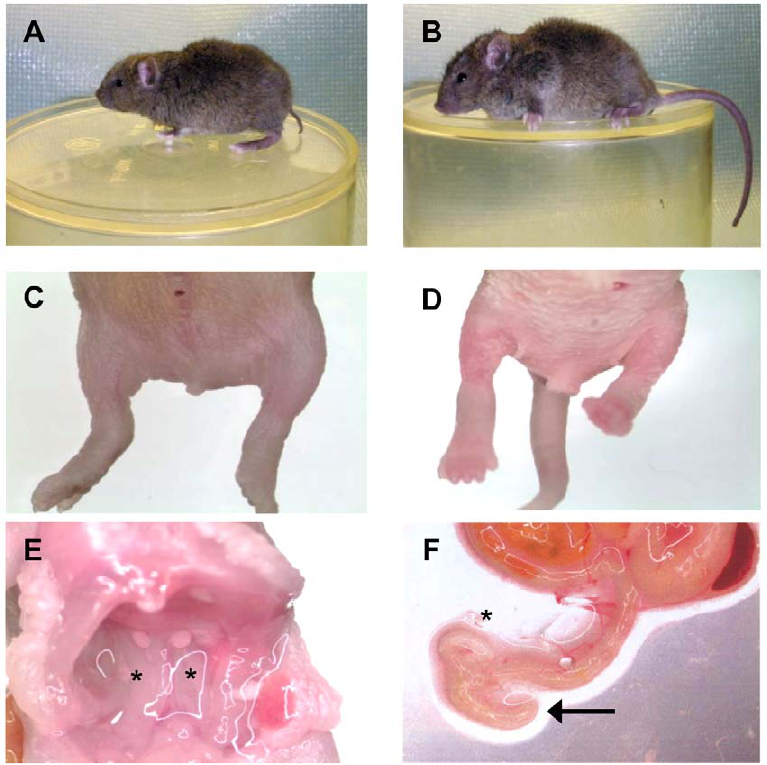
Figure 1. The Sd phenotype. A) Heterozygous ( Sd / + ) mouse. B) Wildtype ( + / + ) mouse. C) Homozygous ( Sd/Sd ) P0 neonate. Note the lack of urogenital openings and tail. D) Wildtype ( + / + ) P0 neonate. E) Homozygous ( Sd/Sd ) mutant neonate showing bilateral kidney agenesis. Kidney location indicated by asterisks below the normally formed adrenal glands. F) Homozygous ( Sd/Sd ) mutant intestine. The colon ends blindly (indicated by arrow), never connecting to the rectum which is never formed (see panel C). The asterisk indicates normal formation of the caecum.